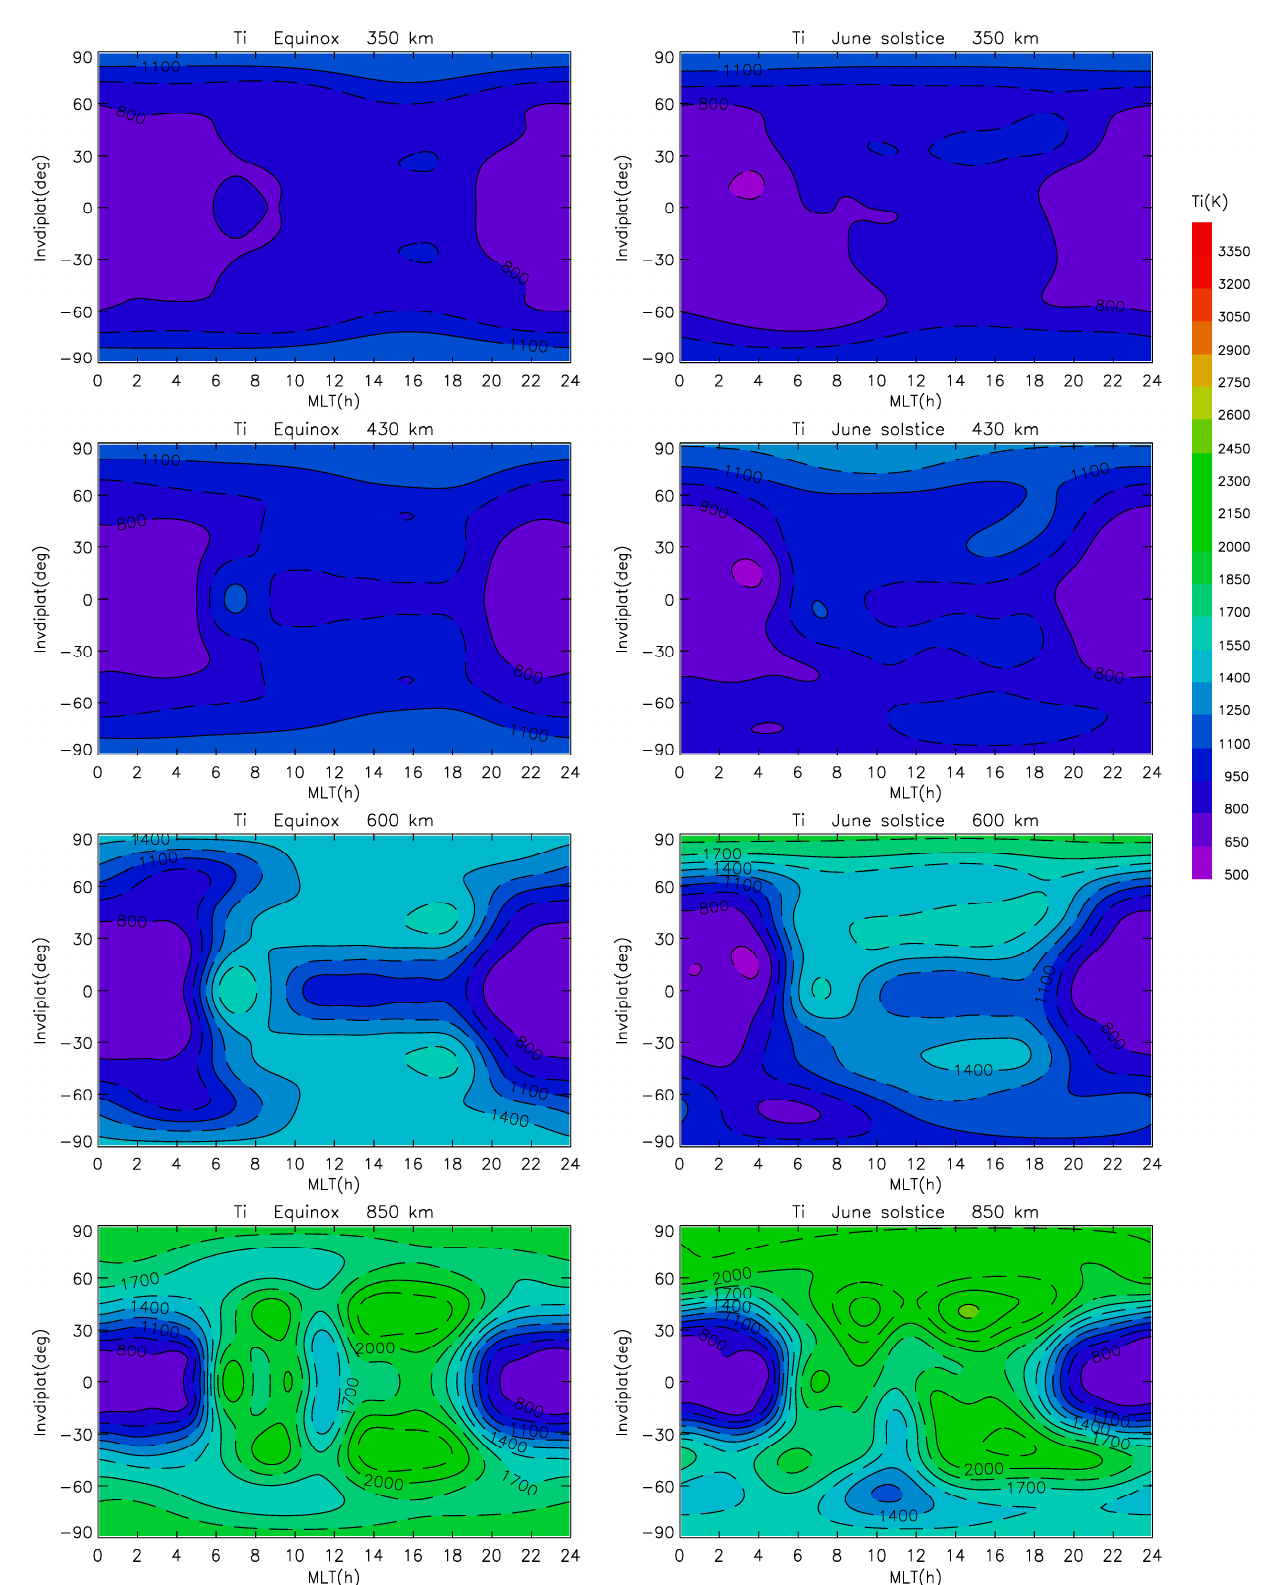
Figure 5. Contour plots of the Ti model for equinox and solstice for the four anchor altitudes during solar minimum (PF10.7 = 70).